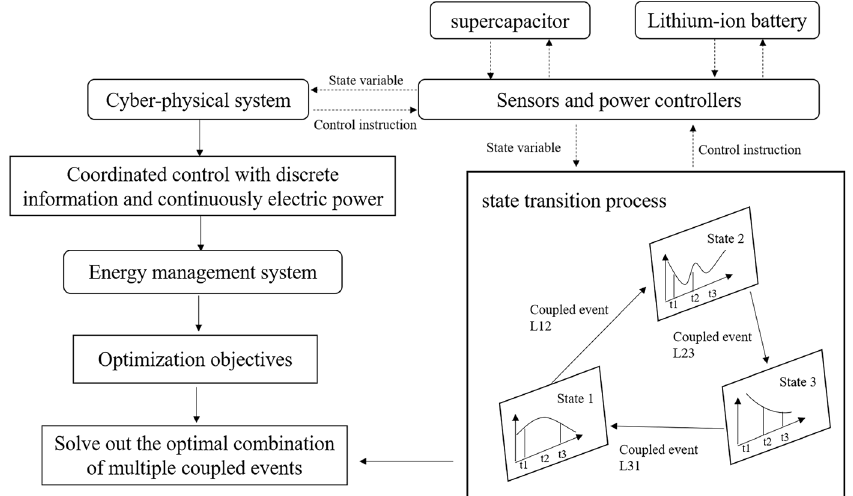
Figure 6. The procedure to control the HESS based on the concept of CPS.